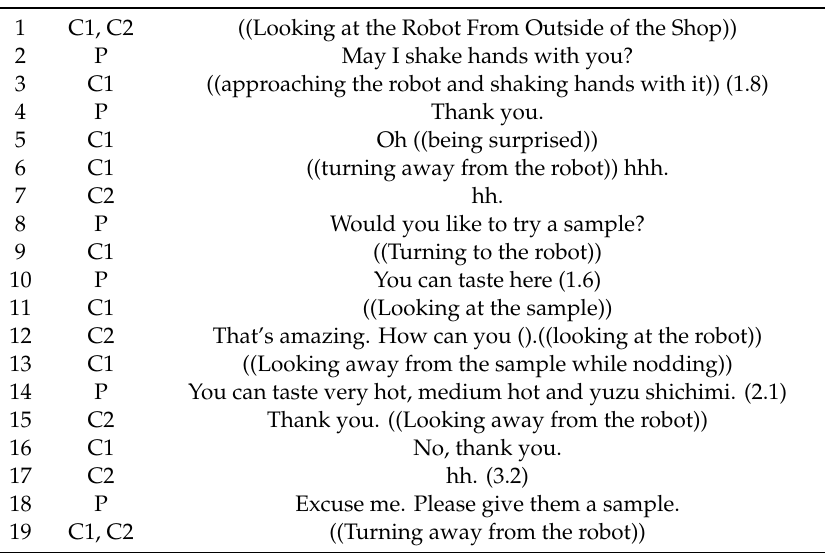
Table 5. Conversation with a group that looked at the sample but did not taste it after the robot’s suggestion (27 November